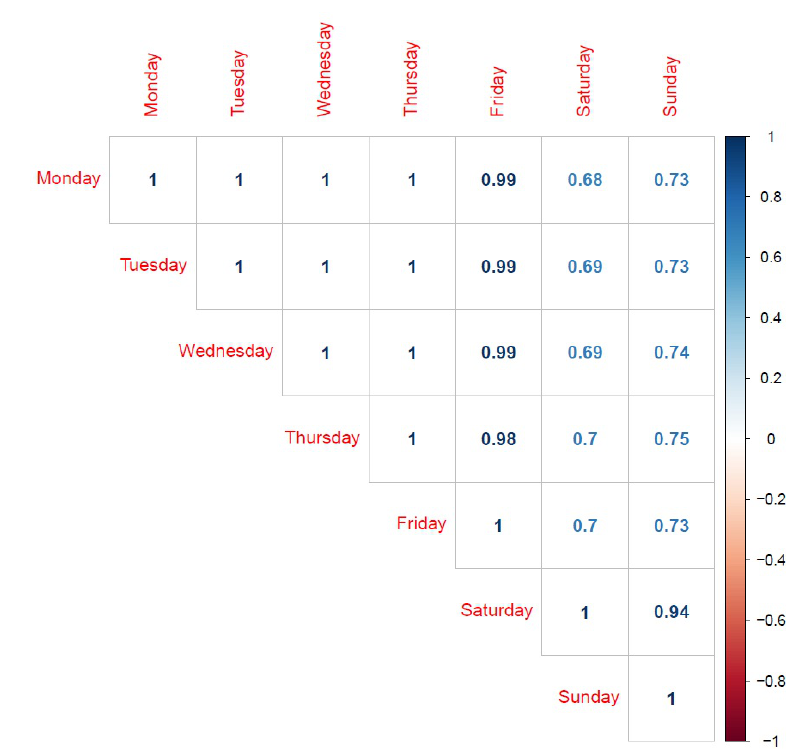
Figure 2. Pearson’s correlation coefficients of daily